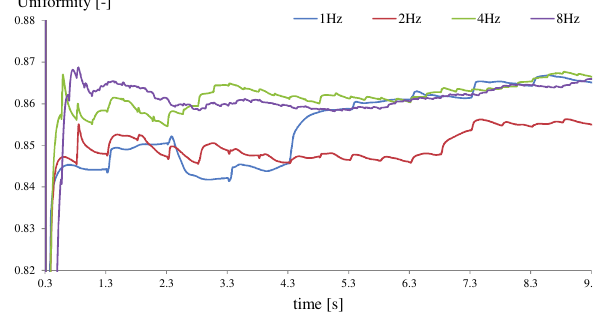
Fig. 4. Uniformity index at SCRoF inlet for medium